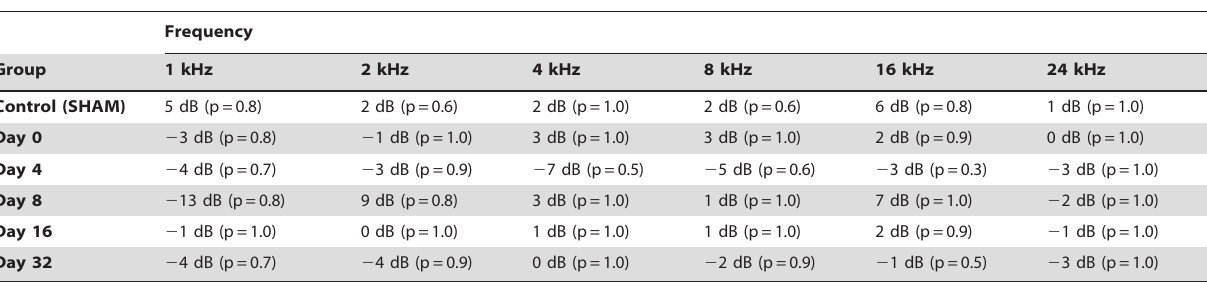
Table 2. Post Acoustic Trauma Threshold shifts in all exposure groups (Contralateral